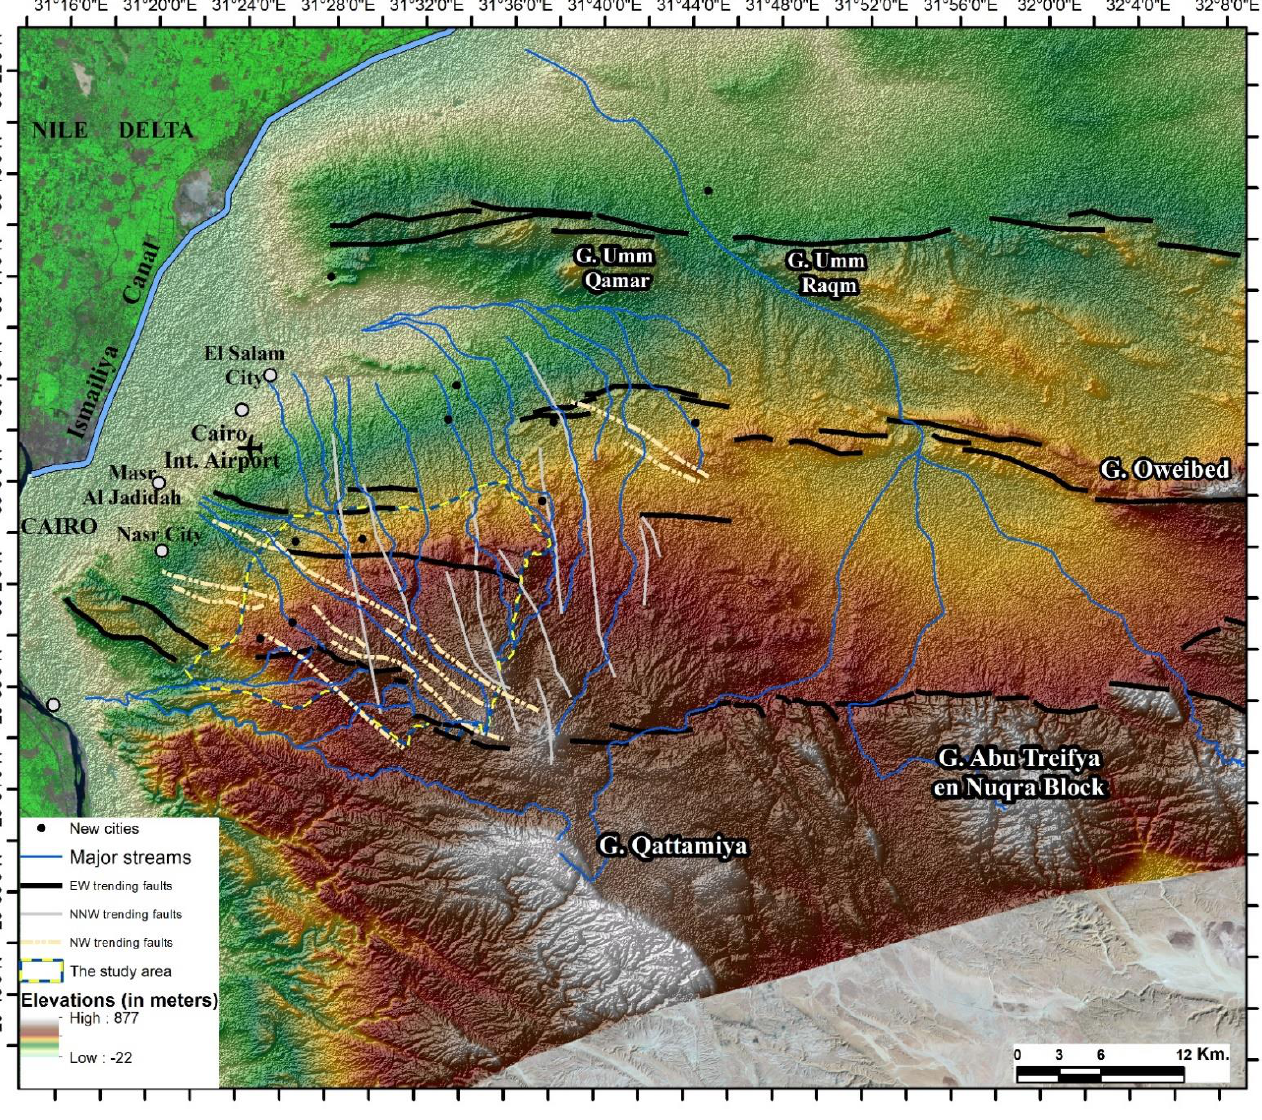
Figure 5. The major tectonic fault trends in the areas east of Cairo.